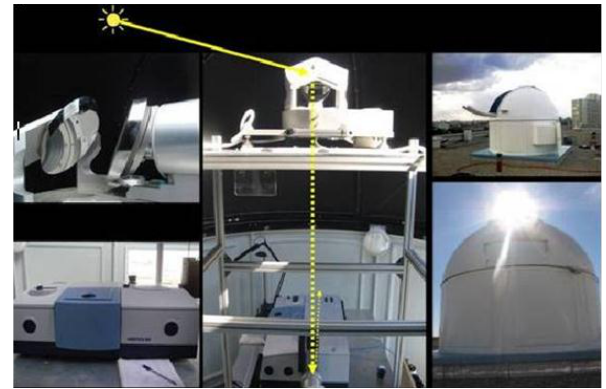
Fig. 1. OASIS observatory: sun tracker (upper-left photo) has two mobiles mirrors which collect and reflect sunlight into the spectrometer (down-left photo) as shown in the middle. In order to protect all these instruments, they are placed into a motorized dome (right photos).